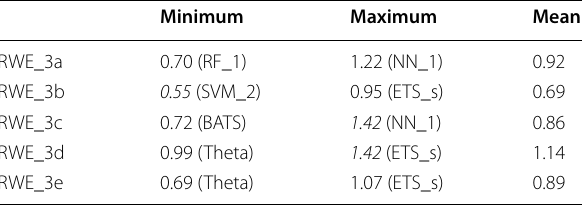
Table 12 Minimum, maximum and mean values of the MdoAE within the experiments using the StandPrecDat